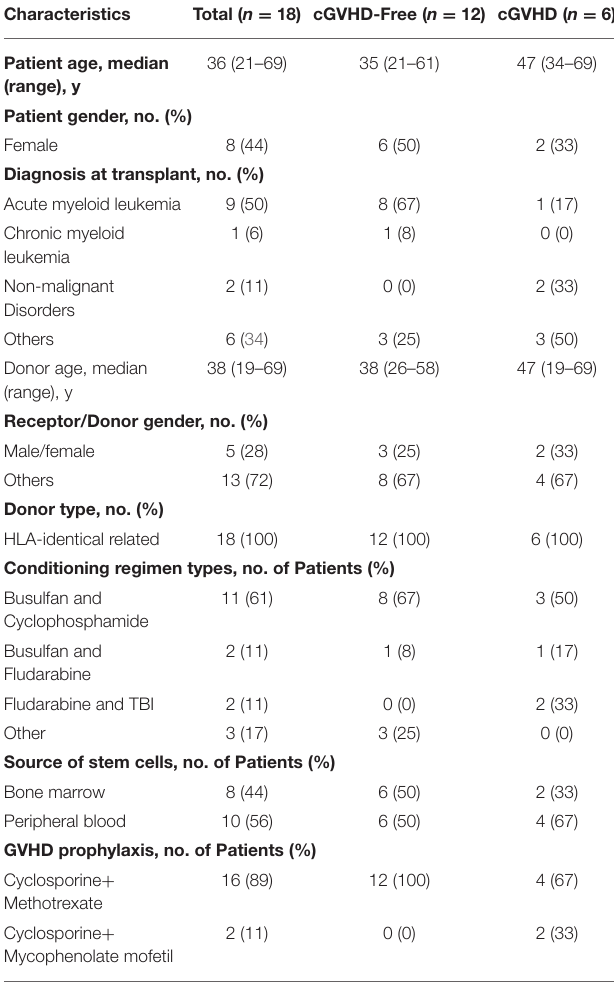
TABLE 1 | Demographic and characteristics of discovery cohort (Brazilians).